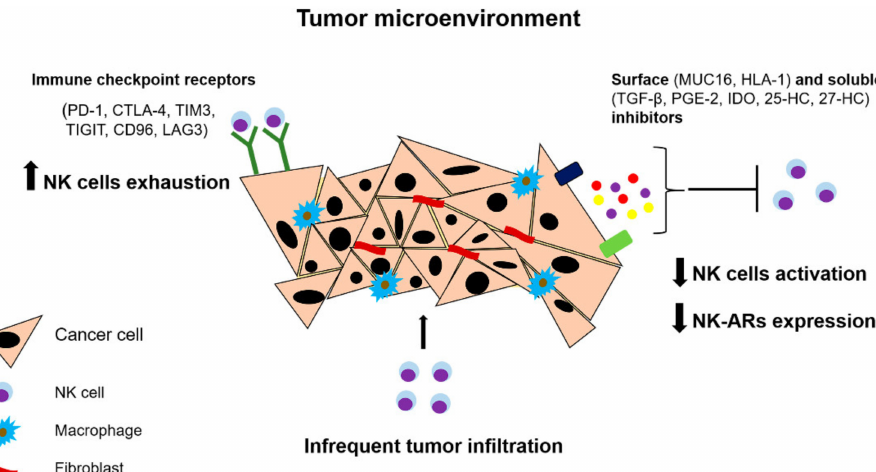
Figure 2. Influence of microenvironment of solid tumors on NK cell functionality. The tumor microen- vironment promotes reducing NK cell functionality via production of different soluble and surface inhibitors negatively affecting activation, maturation, proliferation and effector functions of NK cells. Infrequent tumor infiltration decreases the chance of NK cells to migrate in tumor foci. Abbrevia- tions: PD-1, programmed cell death 1; CTLA-4, cytotoxic T-lymphocyte-associated protein-4; IDO, indoleamine 2,3-dioxygenase; HLA-1, Human leukocyte antigen 1; LAG3, Lymphocyte-activation gene 3; MUC16, Mucin 16; NK-ARs, activating NK cell receptors; TGF- β , transforming growth factor- β ; PGE-2, prostaglandin E2; TIGIT, T cell immunoreceptor with Ig and ITIM domains; TIM3, T-cell immunoglobulin domain and mucin domain 3; 25-HC, 25-hydroxycholesterol; 27-HC,